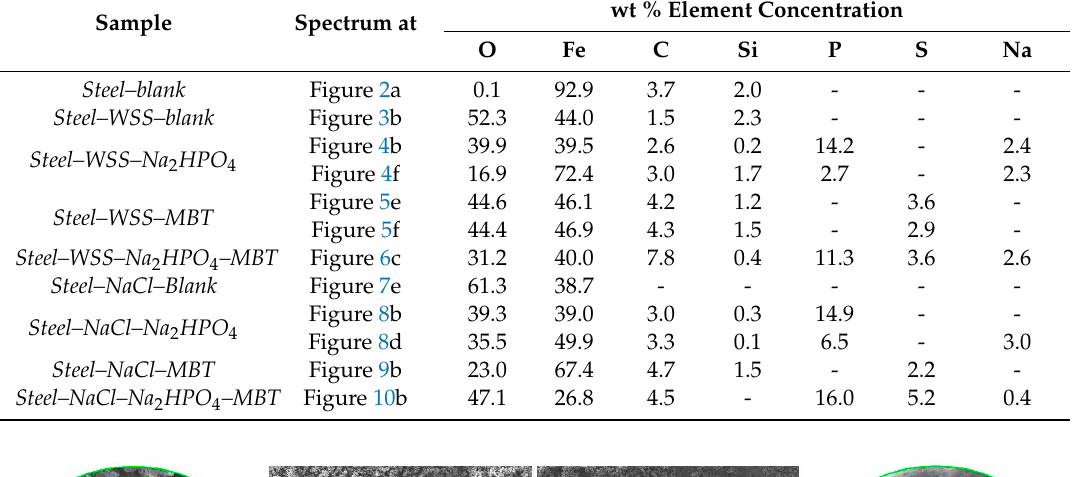
Figure 5. SEM images of mild steel immersed in WSS for 96 h in the presence of MBT.